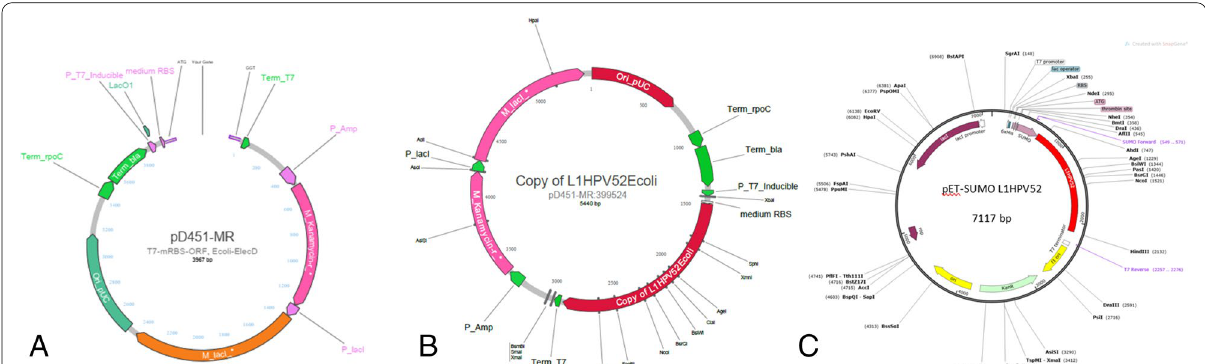
Fig. 1 Arrangements of L1-HPV52 gene target inside both cloning and expression vectors. A Plasmid map of original pD451-MR from ATUM, which has 3967 bps. B The plasmid pD451-MR harboring codon-optimized truncated L1-HPV52 with 26 aa truncations, which makes 5440 bps. C